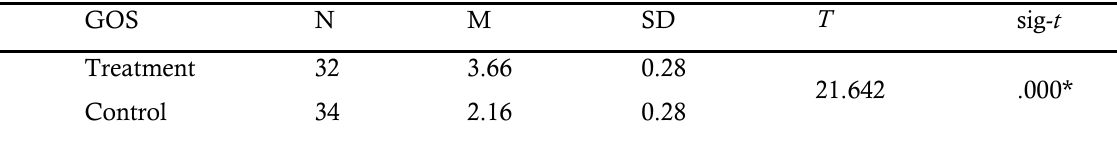
Table 1.4. Results of independent sample t-test between treatment group and control group on adolescents’ goal orientation behavior mean score at